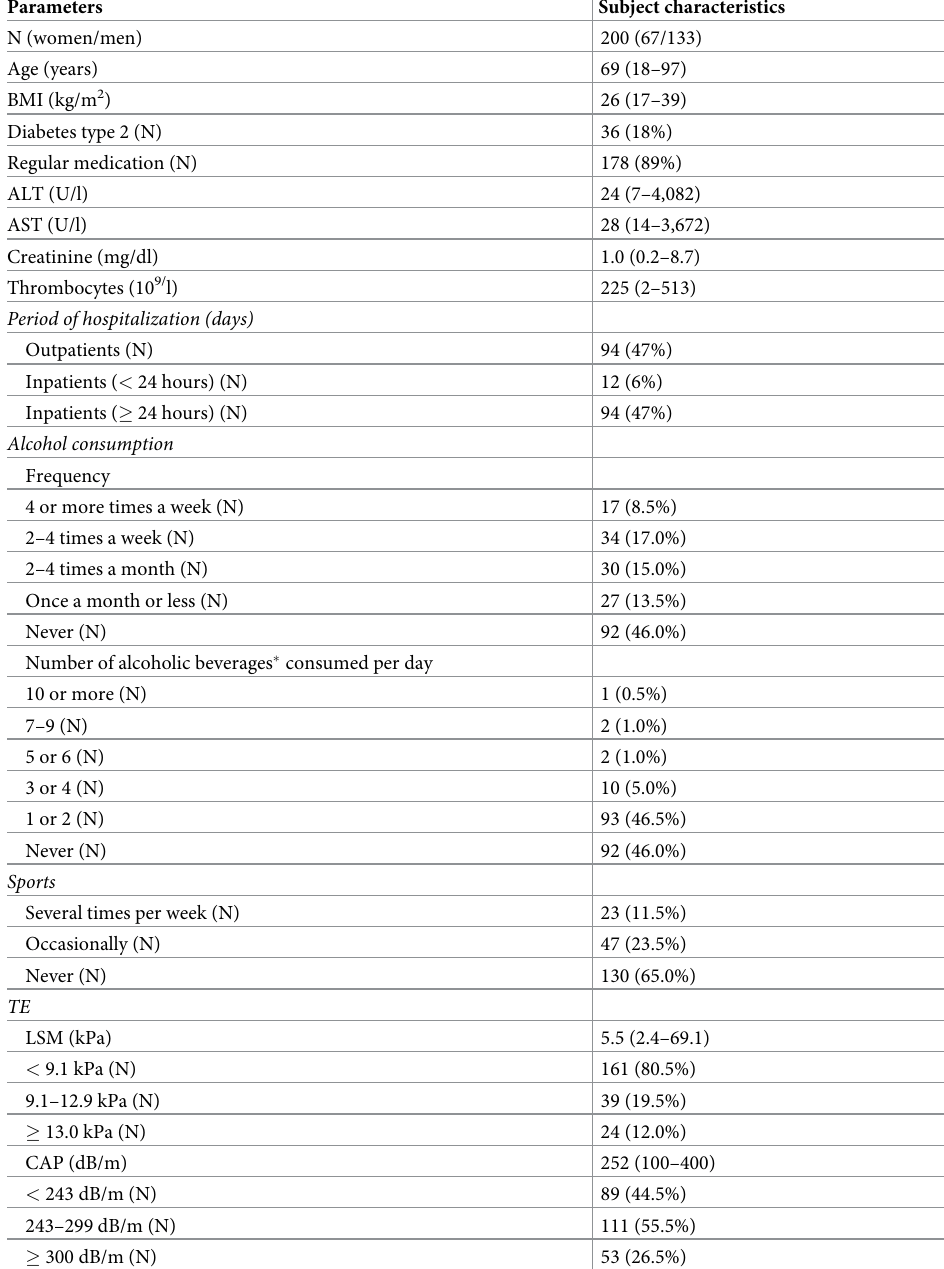
Table 1. Clinical characteristics of the study